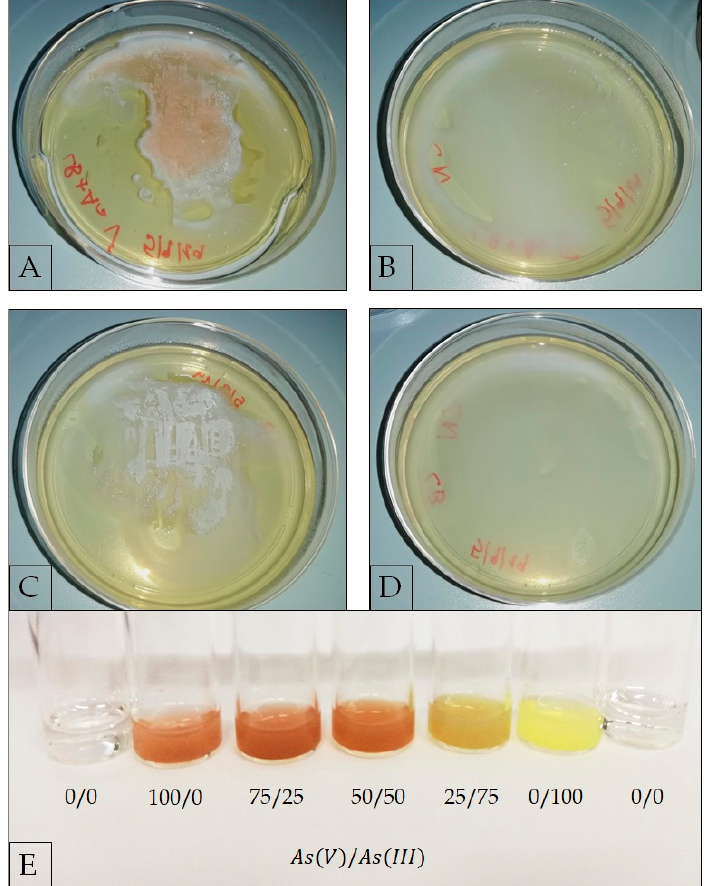
Figure 4. Silver nitrate test on: ( A ) G. stearothermophilus GF16 grown on LB-agar plate supplemented Figure4. Silvernitrateteston: ( A ) G.stearothermophilus